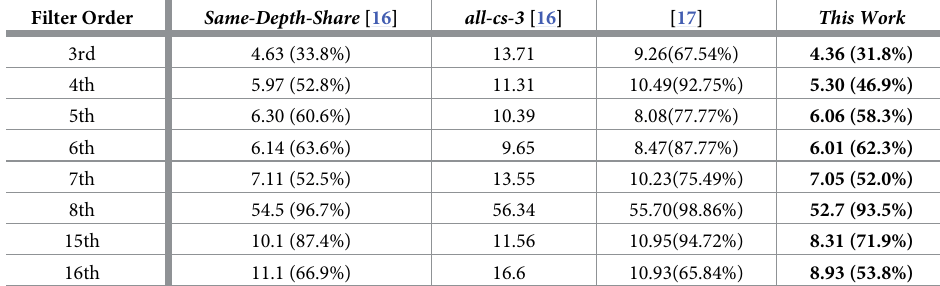
Table 3. Comparison of average absolute output error (x10 − 3 ) for different order FIR filters.